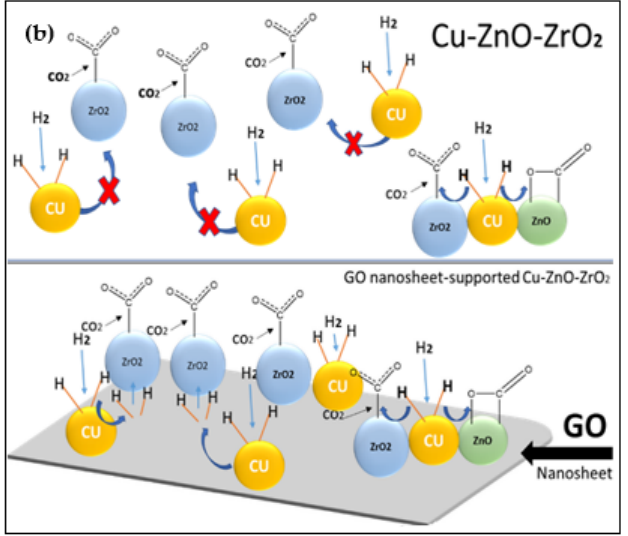
Figure 6. Selectivity (CZZ) with GO and GO oxide ‐ free (CZZ) by different temperatures ( a ), and graphene oxide nanosheet as a bridge, promoting hydrogen spillover from the surface of copper to the surface of other metal oxides ( b ) (adapted from [90] with permission from Elsevier).